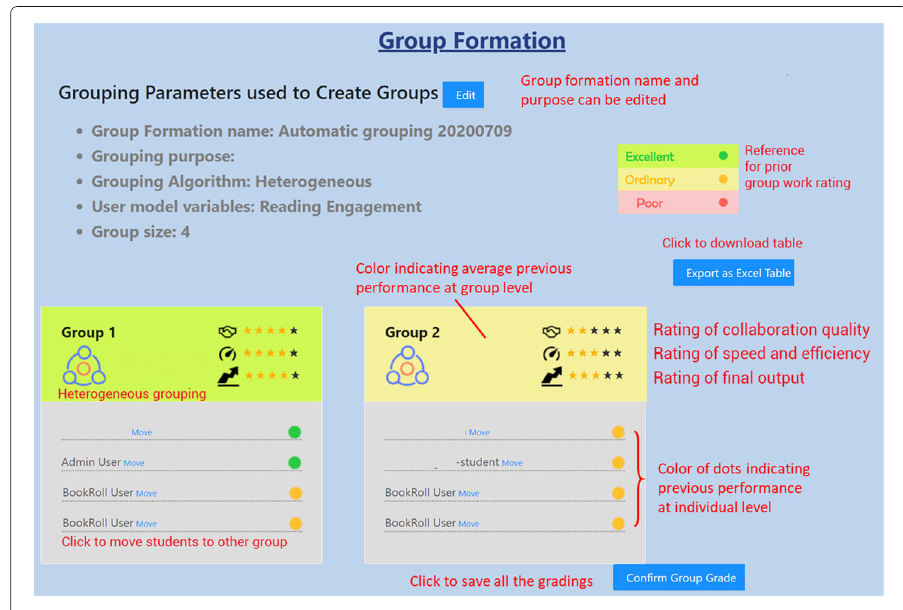
covers 7 lecture topics of 11 in-class activities (see Table 5, “TG” means groups formed by the teacher, and “CG” means groups formed by